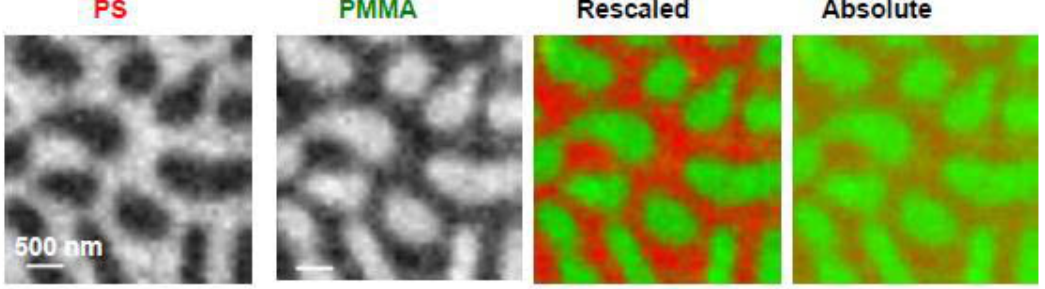
Appendix Figure 1. Component maps for PS and PMMA of a PS/PMMA 30/70 blend obtained from STXM. PS color coded in red, PMMA color coded in green. Rescaled image shows phase segregation of the two polymers. Absolute image shows that there is a layer of PMMA all across the sample, which is not from intermixing, but rather from segregation of the PMMA to the mica substrate on which it was spun cast. X-PEEM studies of that surface (results not shown) also show a PMMA rich coating over the bulk PS/PMMA domain